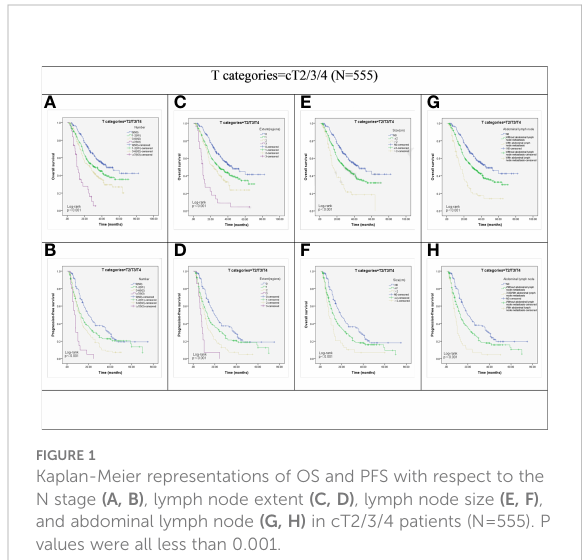
FIGURE 2 Kaplan-Meier representations of OS and PFS with respect to the N stage (A, B) , lymph node extent (C, D) , lymph node size (E, F) , and abdominal lymph node (G, H) in cT2/3 patients (N=448). P values were all less than